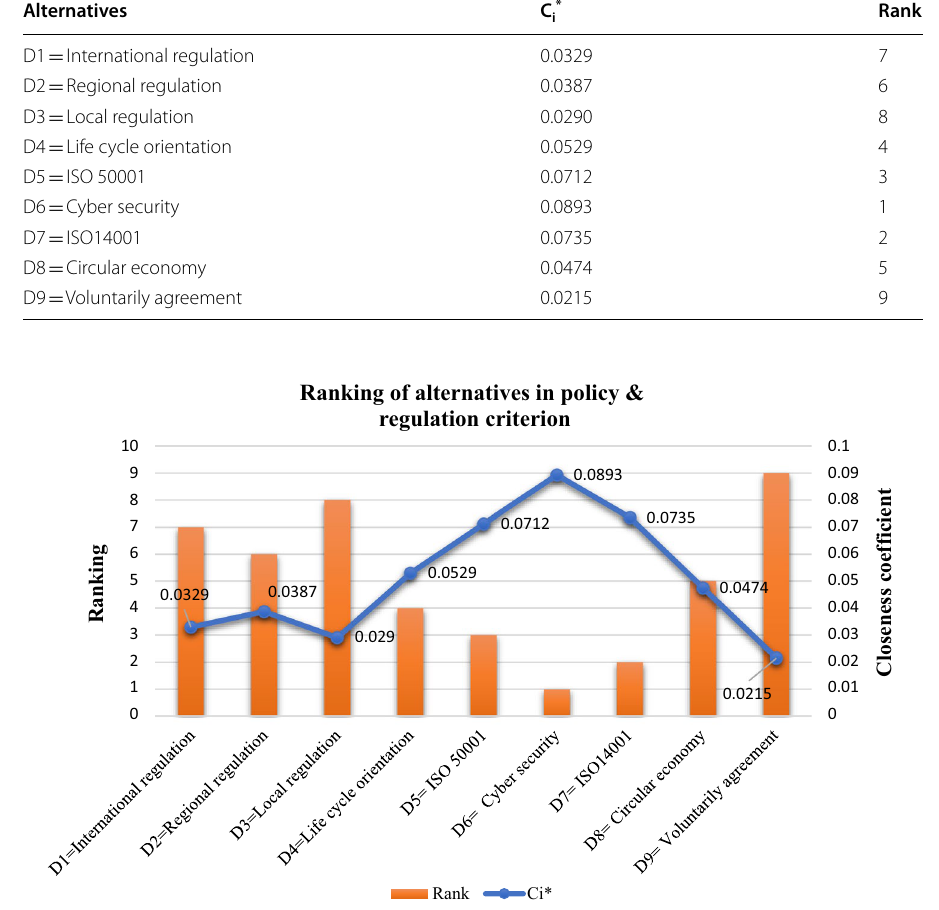
Fig. 13 Ranking of alternatives in the policy and regulation